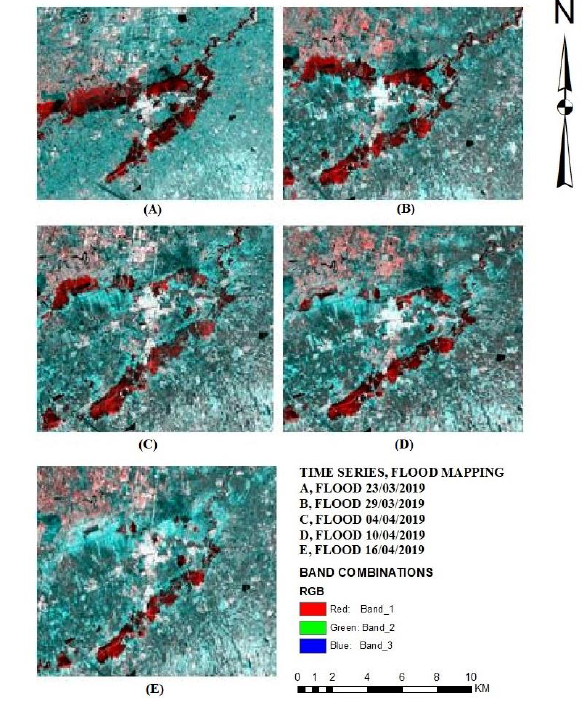
Figure 6. Time series flood mapping of Aq’qala city